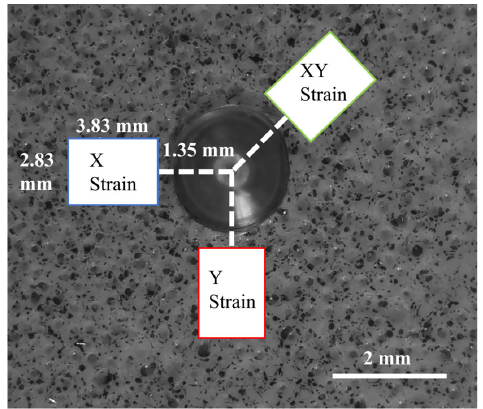
Figure 8. Positioning of the virtual extensometers for calculating X, Y and XY strains.